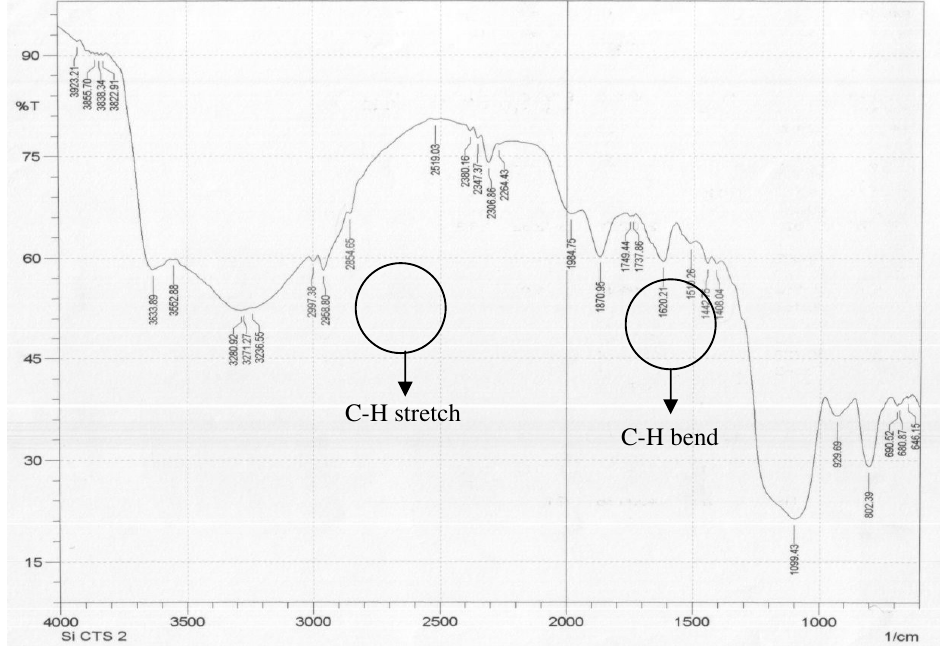
Figure 3. FT-IR spectrum of